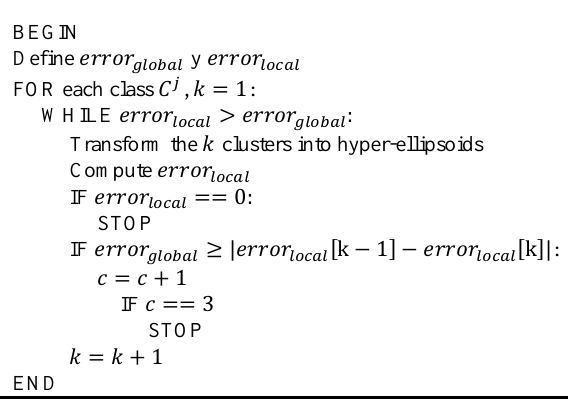
Algorithm 1. Training algorithm for a